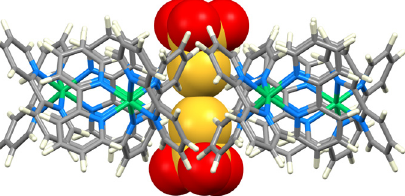
Figure 9. Arrangement of the thiosulfate ions within a {[Ni(bpy) 3 ]} 6 -motif in [Ni(bpy) 3 ][SSO 3 ] . 7H 2 O (refcode KOLXOY) [62]. Table 3. Structure Type I and II complexes with [XY 4 ] m – anions.